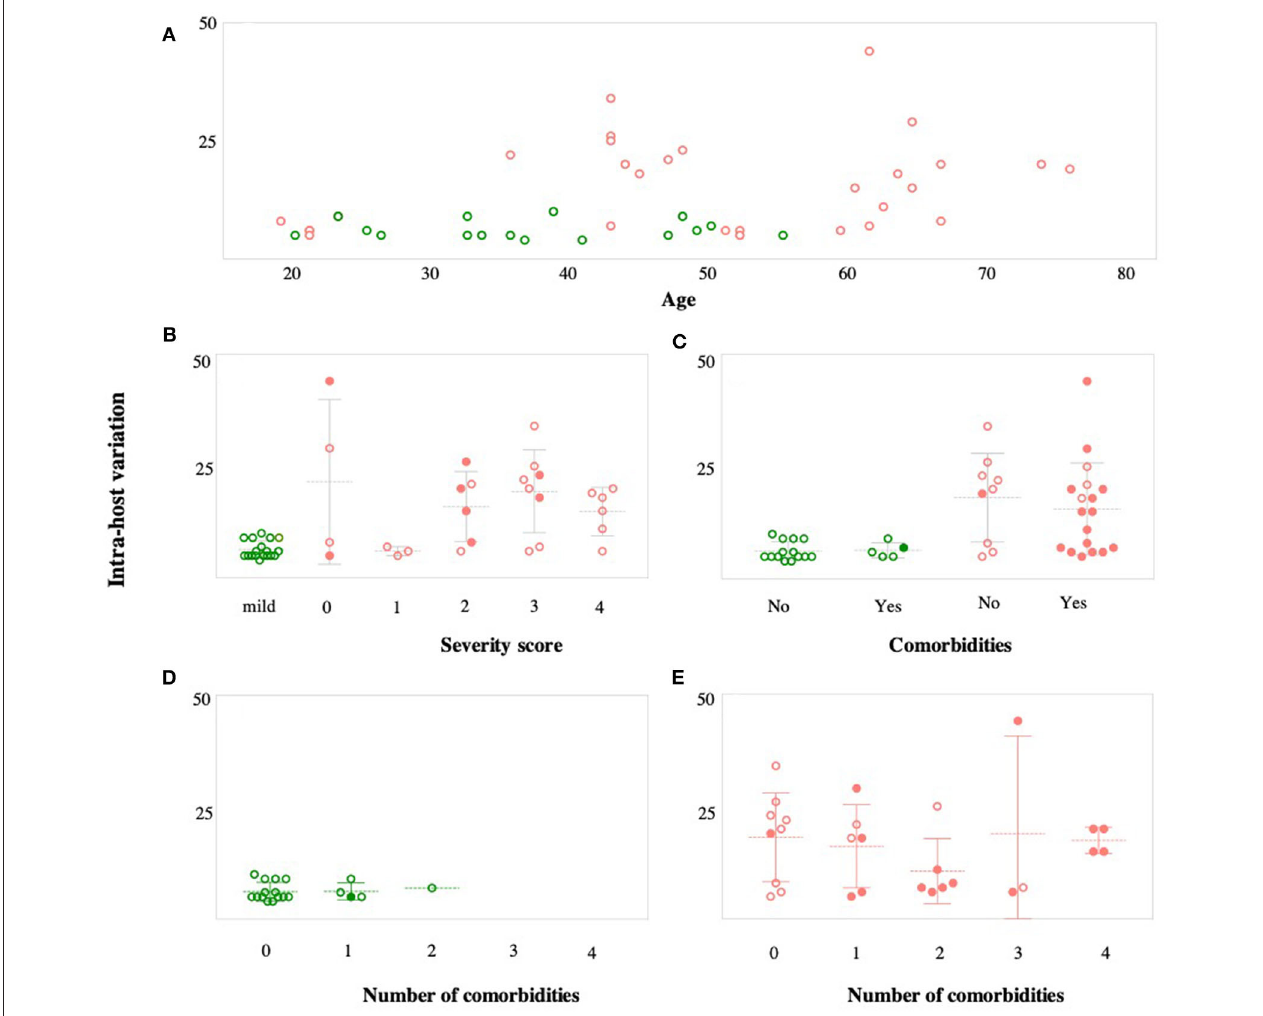
FIGURE 7 | Correlation between within-host variation (number of variants within each patient) and age (A) , severity score (B) , and number of comorbidities (C) . Patients with mild symptoms are indicated in green while patients with severe symptoms are indicated in red. Shaded circles in (B–E) indicate patients older than 50